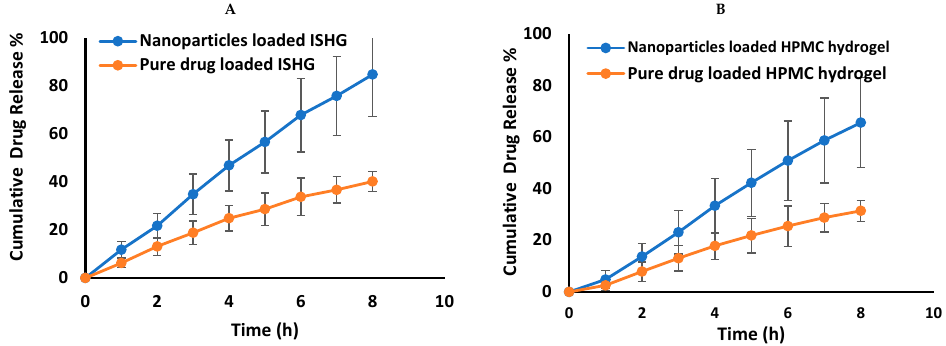
Figure 7. In-vitro FLZ release from nanoparticles and pure drug-loaded ISHG ( A ) and HPMC hydrogels ( B ).